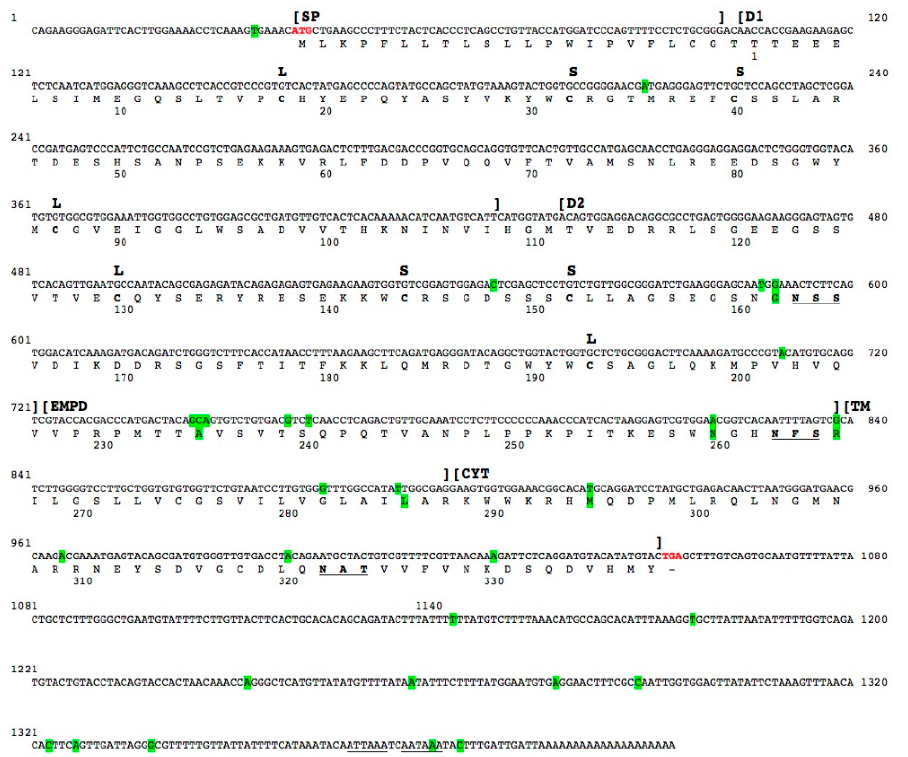
Figure 4. Nucleotide and deduced amino acid sequences of the gene encoding T. bernacchii pIgR. The start and stop codons are given in bold red, and the polyadenylation signals located downstream of the stop codon are underlined. The boundaries of the signal peptide (SP); the D1, D2, and EMPD domains; and the transmembrane (TM) and cytoplasmic (CYT) regions are indicated by square brackets above the nucleotide sequence. Polymorphic sites are highlighted in green. Amino acid residues are reported in one-letter code below the nucleotide sequence. The large (L) and the small (S) loops are indicated above codons for the cysteine residues forming them. N-glycosylation sites defined by the NXS/T sequons are bold and underlined. The numbering of nucleotides and of amino acids residues is reported above and below each sequence, respectively.